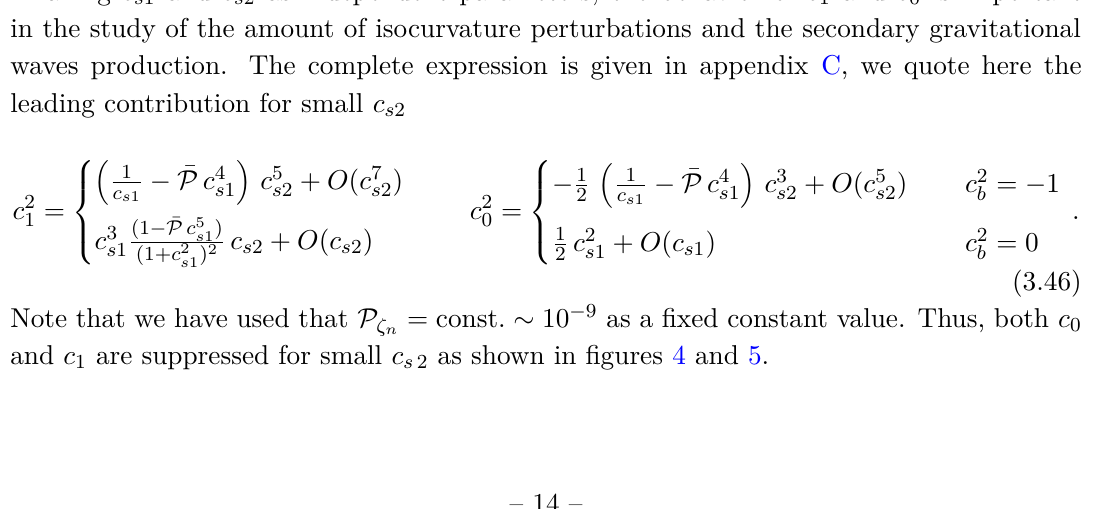
enhancement particularly pronounced in the c 2 R π 0